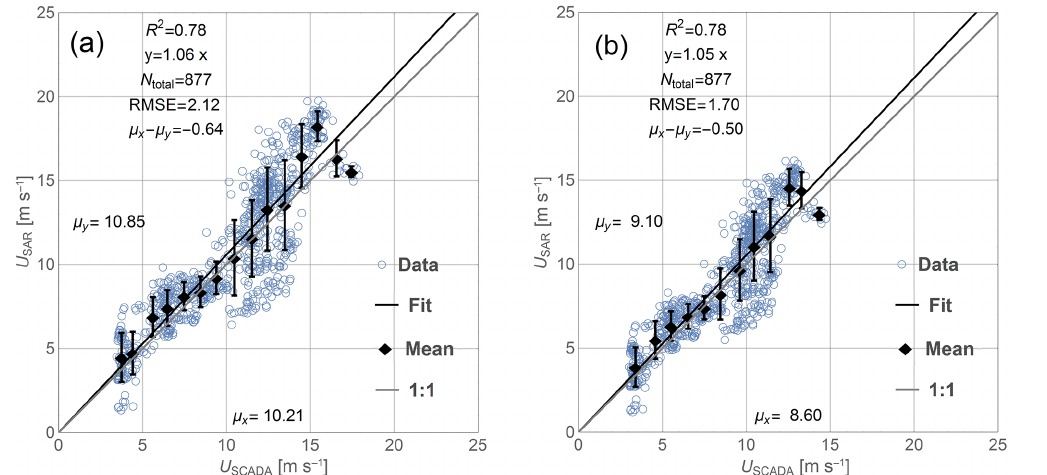
Figure 5. Comparison between SCADA-derived wind speeds ( U SCADA ) and SAR-derived wind speeds ( U SAR ) downstream of the wind turbines: (a) for the turbine hub height (81.6m) and (b) for the reference height (10m).